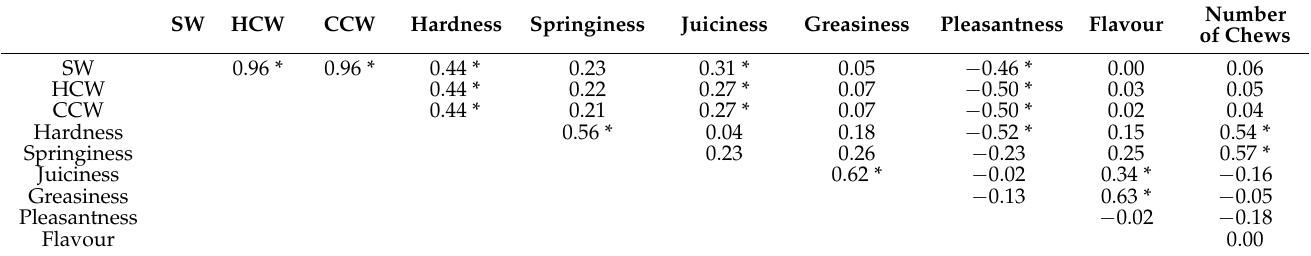
Table 5. Correlation coefficients between zootechnical and sensory variates for Rubia de El Molar lambs’ meat.